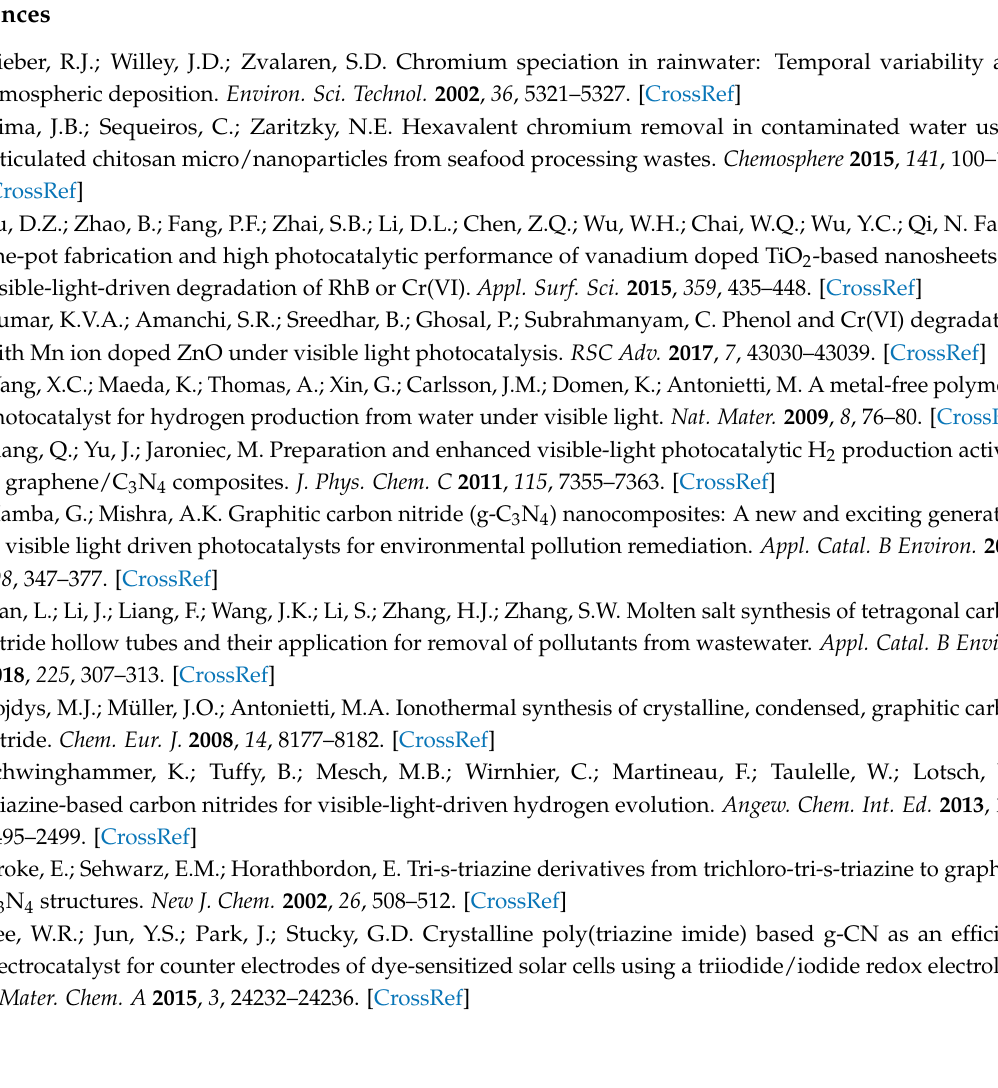
Figure S1: SEM image of heptazine-based g-C 3 N 4 , Figure S2: EDS spectra of PTI/TiO 2 -7 wt% heterojunction, Table S1: BET surface area of the as-prepared